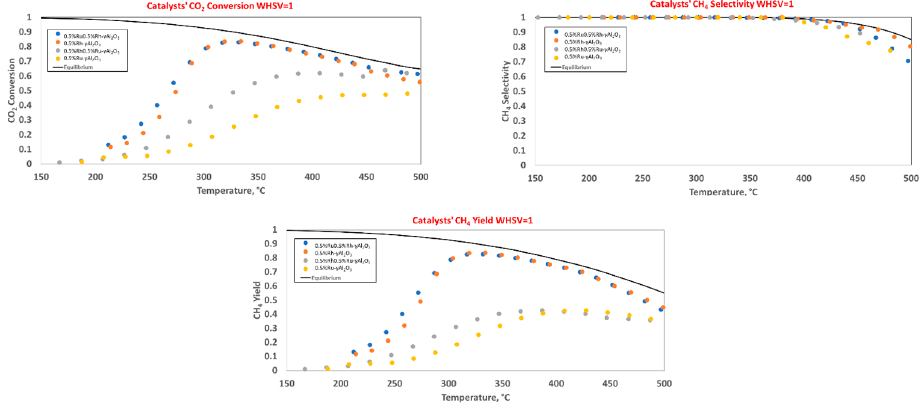
Figure 9 . Catalysts’ CO 2 conversion, CH 4 selectivity and yield at WHSV = 1 NL/g cat h.